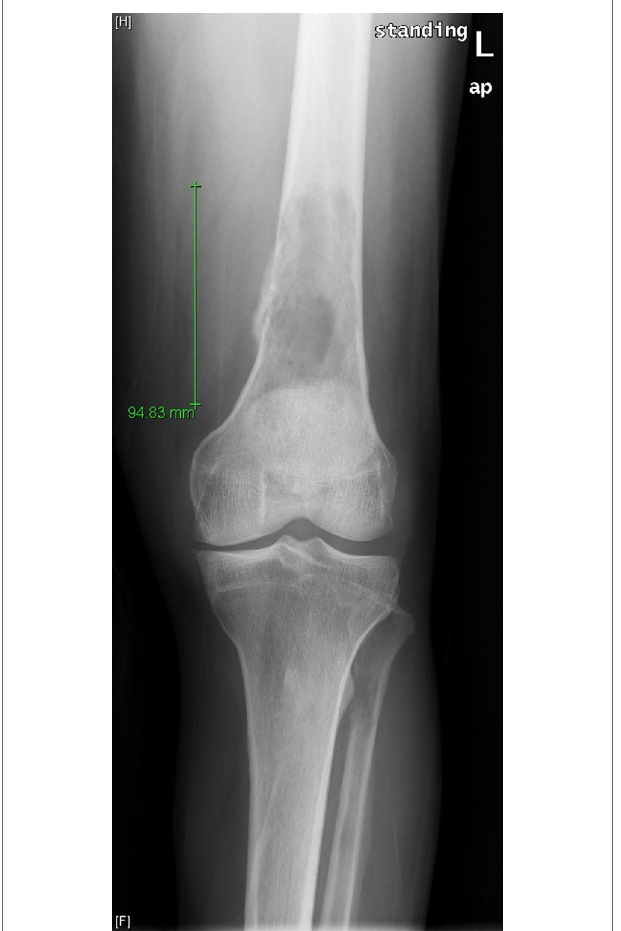
FIgURe 1 | Frontal radiograph of the left femur demonstrates a large lytic lesion of the distal diaphysis with wide zone of transition and aggressive­ appearing periosteal reaction at the medial